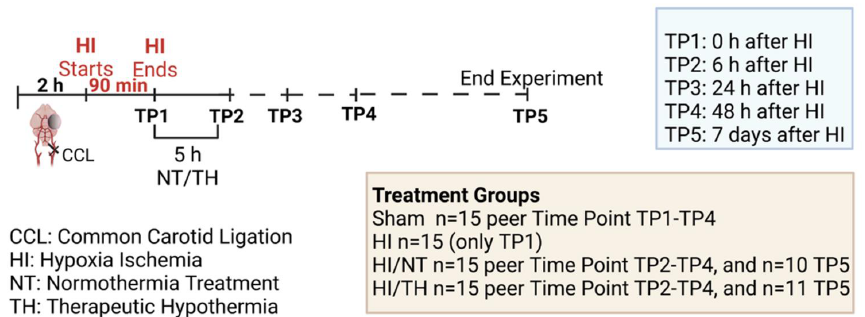
Figure 6. Experimental design: 7-day-old rats (P7) were randomized according to sex and weight into four different treatment groups. Sham animals were not ligated and were only exposed to anesthesia for a short period of time (n = 15 animals per time point and condition). Common carotid ligation (CCL) was performed in the other groups, and animals were thereafter exposed to 90 min of hypoxia treatment (8% O 2 , 36 ◦ C), resulting in moderate unilateral hypoxic-ischemic (HI) brain injury. After hypoxia (time point 1—TP1, n = 15 animals), HI animals were sacrificed immediately after HI. Following HI, the remaining ligated animals were treated with either normothermia treatment (NT) (37 ◦ C) or hypothermia treatment (TH) (32 ◦ C) for 5 h. Blood, spleen, bone marrow, and brains were isolated at different time points (immediately, 6 h, 24 h, and 48 h (n = 15 animals per time point and condition)) after HI. Animals from the last time point (seven days after HI) were sacrificed, and brain slices were stained with hematoxylin to measure the area loss after HI/NT (n = 10) or HI/TH treatment (n = 11). Made using